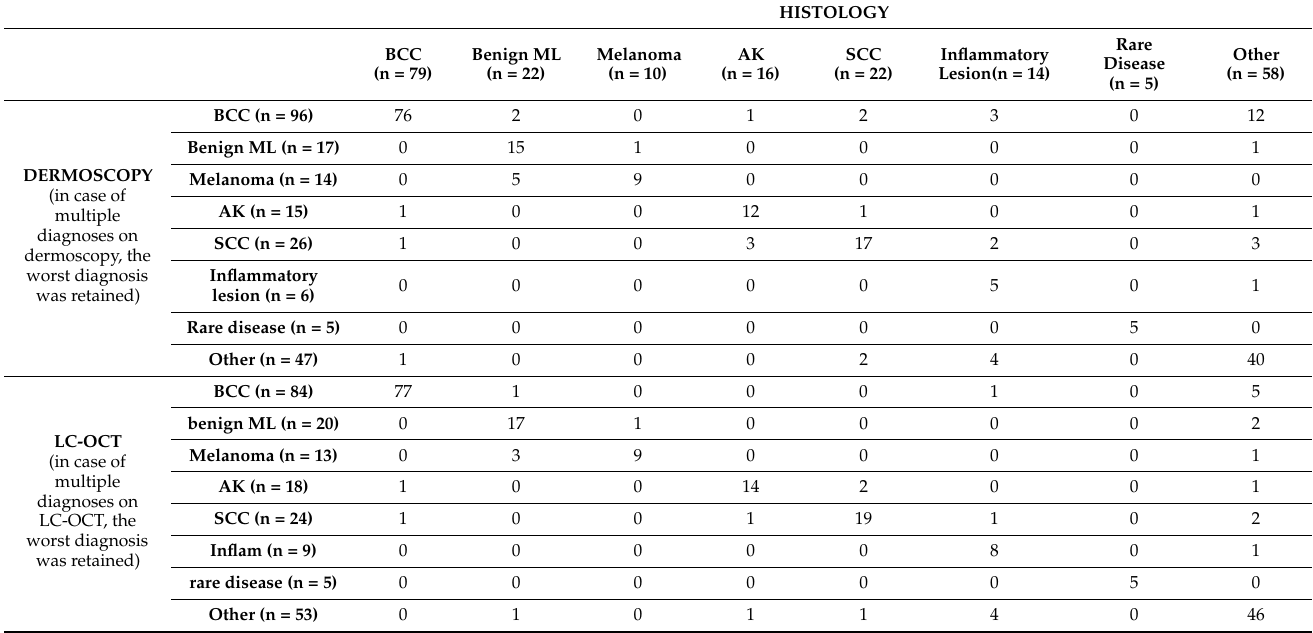
Table 1. Confusion matrix: dermoscopy vs. histology and LC OCT vs. histology.